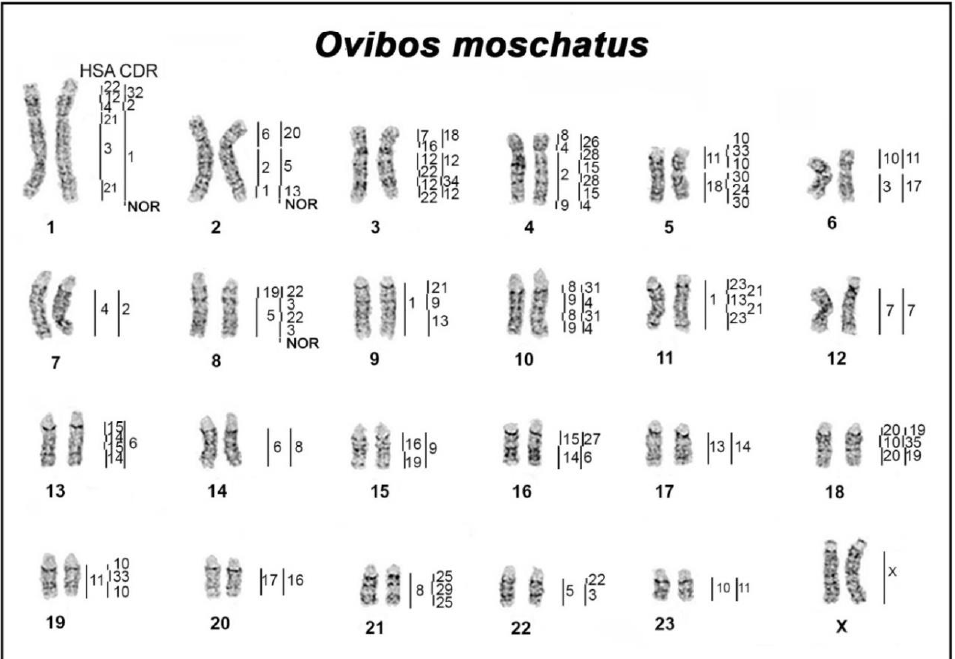
Figure 2. Chromomycin A 3 -DAPI after G-banding (CDAG) staining performed on metaphase chromosomes of musk ox: GTG-banding (left) and CMA3/DAPI-staining after denaturation and renaturation procedure (right). We studied the distribution of repeated sequences in the musk ox karyotype using several methods. FISH analysis revealed the localization of telomere repeat and ribosomal DNA sequences. Six nucleolar organizing regions (NORs) with telomeric localization on OMO 1, OMO 2 and OMO 8 chromosome pairs were identified (Figure 1). Telomeric repeats are situated on terminal regions of chromosomes. The CDAG differential staining revealed centromeric and telomeric GC-enriched heterochromatin with prominent AT- and GC-enriched pericentromeric blocks of heterochromatin on acrocentric chromosomes (Figure 2). Smaller blocks of heterochromatin were observed on meta- and submetacentric chromosomes, except chromosome 6, where a large block of heterochromatin was identified. Enlarged telomeric blocks were observed on at least 3 pairs of autosomes, while only